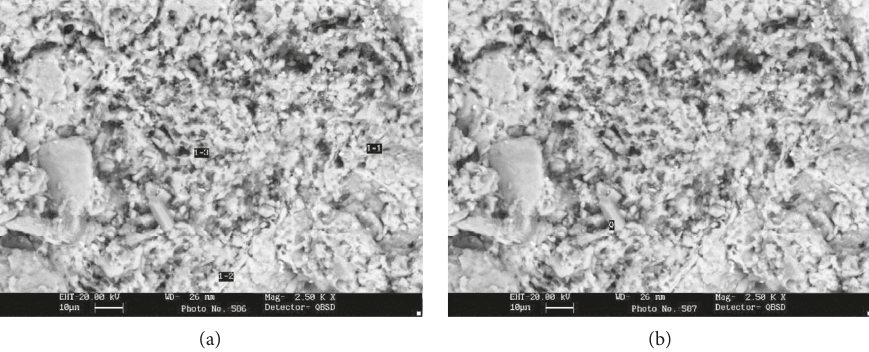
Figure 6: Energy spectrum pictures of red clay samples in Tiyu west road station. (a) × 2500 1-1 I/S; 1-2 I/S; 1–3 C/S. (b) × 2500 1–4 authigenic quartz